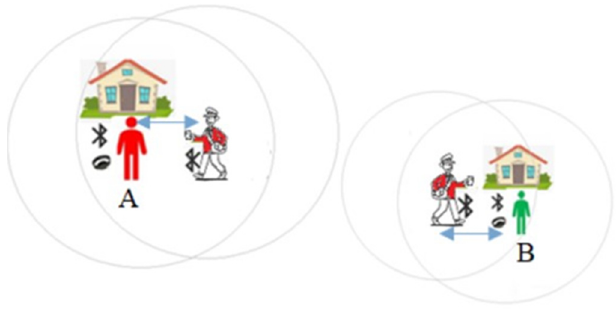
Figure 10. A schematic of wearable-based COVID-19 proximity tracing.